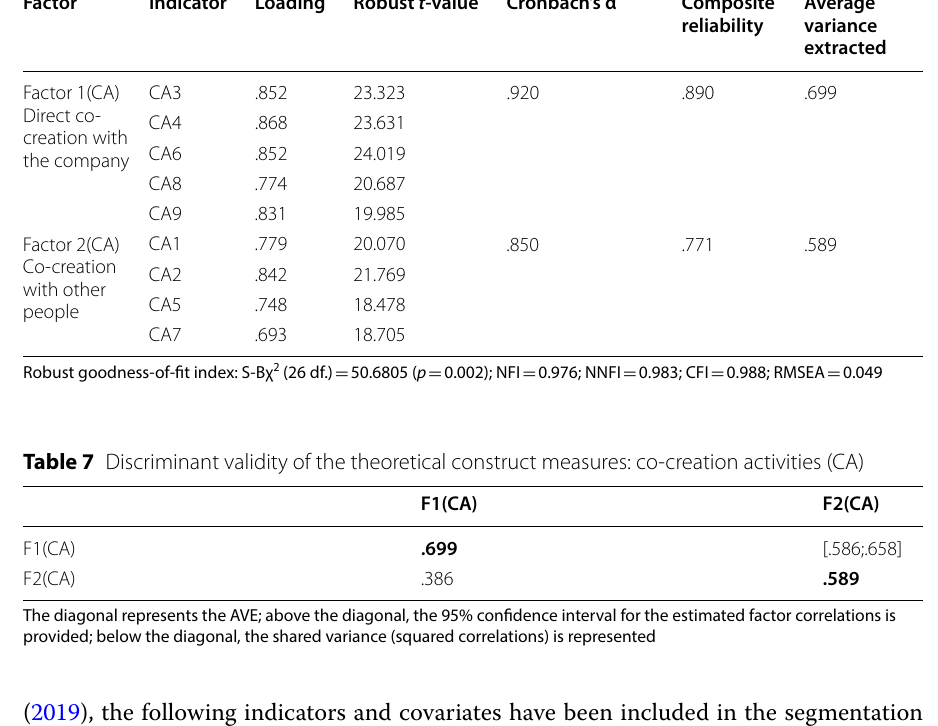
Table 6 Internal consistency and convergent validity: co‑creation activities